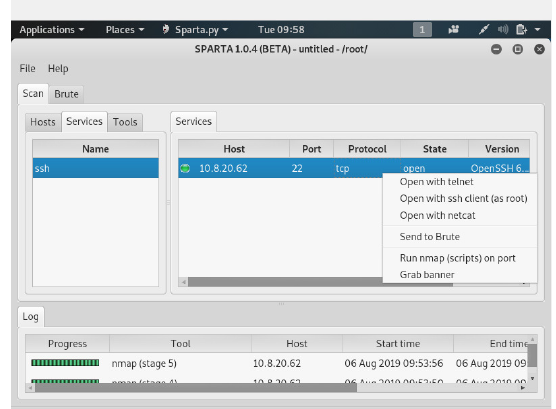
Fig. 14: Types of Implemented